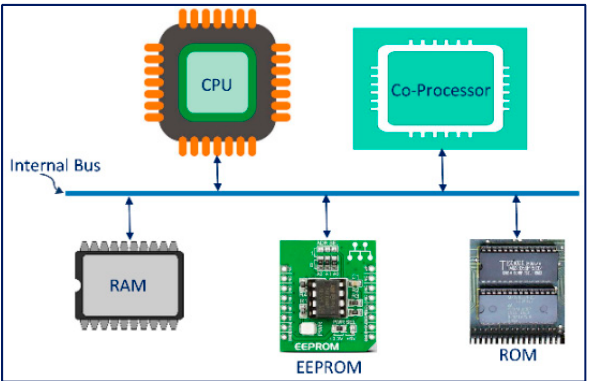
Figure 1. Architecture of a smart card. CPU: central processing unit, ROM: read-only memory, RAM: random access memory, EEPROM: electrically erasable programmable read-only memory.